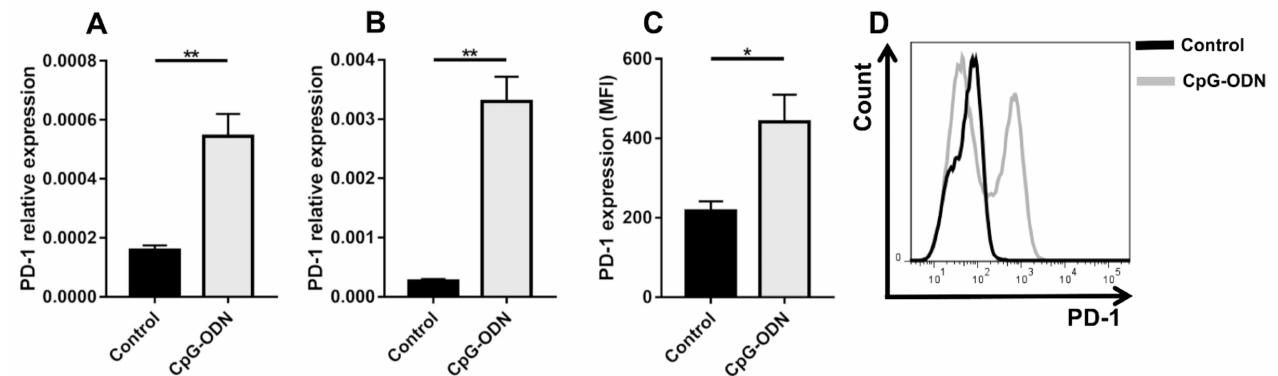
Figure 1. CpG-ODN treatment induces PD-1 expression on peritoneal immune cells in vitro and in vivo. PD-1 mRNA expression, as quantified by real-time PCR, in adherent ( A ) and nonadherent ( B ) peritoneal immune cells isolated from healthy mice and stimulated in vitro with 1 µ M CpG-ODNs for 24 h. The data were normalized to the expression of β 2m as a housekeeping reference gene and analyzed by the comparative 2 − ∆ Ct method. ( C ) Mean fluorescence intensity (MFI) and ( D ) a representative histogram plot of PD-1 expression on peritoneal CD45 + cells isolated from healthy nude mice treated i.p. with 20 µ g/mouse CpG-ODNs or saline for 4 consecutive days. Black line: control; Gray line: CpG-ODN. The data are presented as the mean ± SEM. * p < 0.05 and ** p < 0.01 by two-tailed unpaired Student’s t -test. CpG-ODNs: CpG